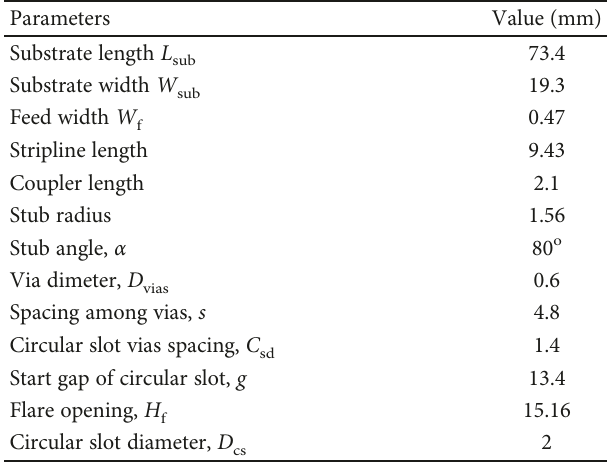
results of the proposed SCVA. 11 Table 2: Optimized parameters of the proposed SCVA